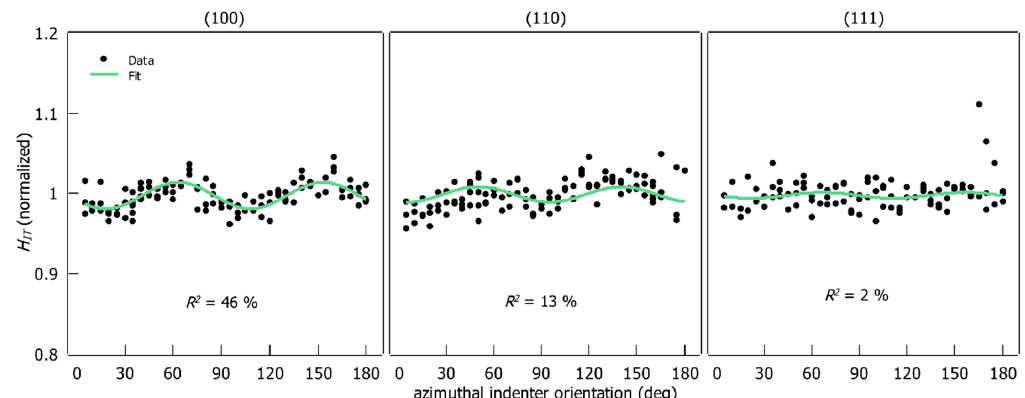
Figure 8. H IT (normalized to the mean values) as a function of the azimuthal indenter orientation on three crystallographic orientations.